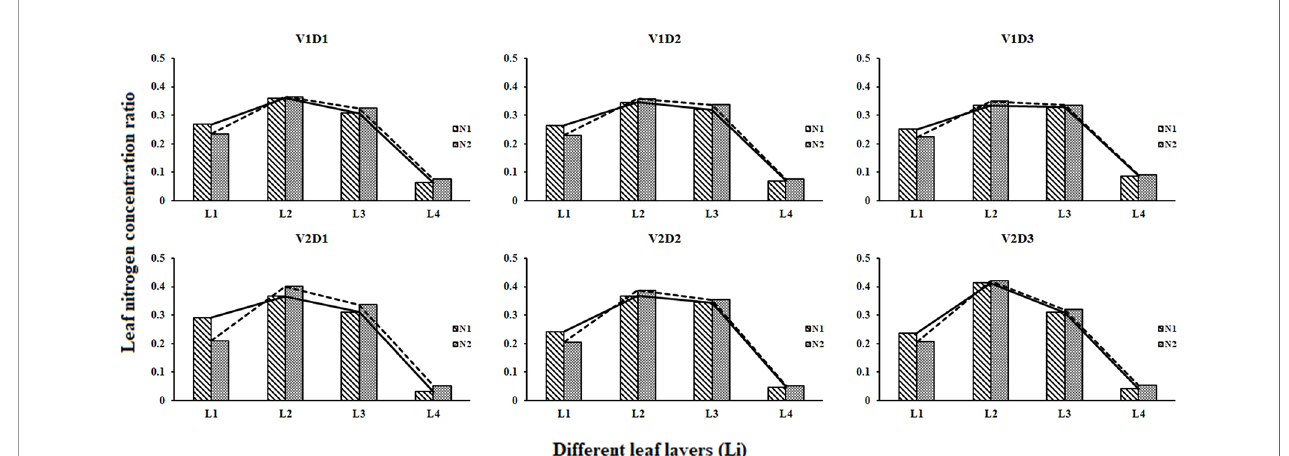
FIGURE 4 | Leaf nitrogen concentration ratio of different leaf layers under different treatments (2015).